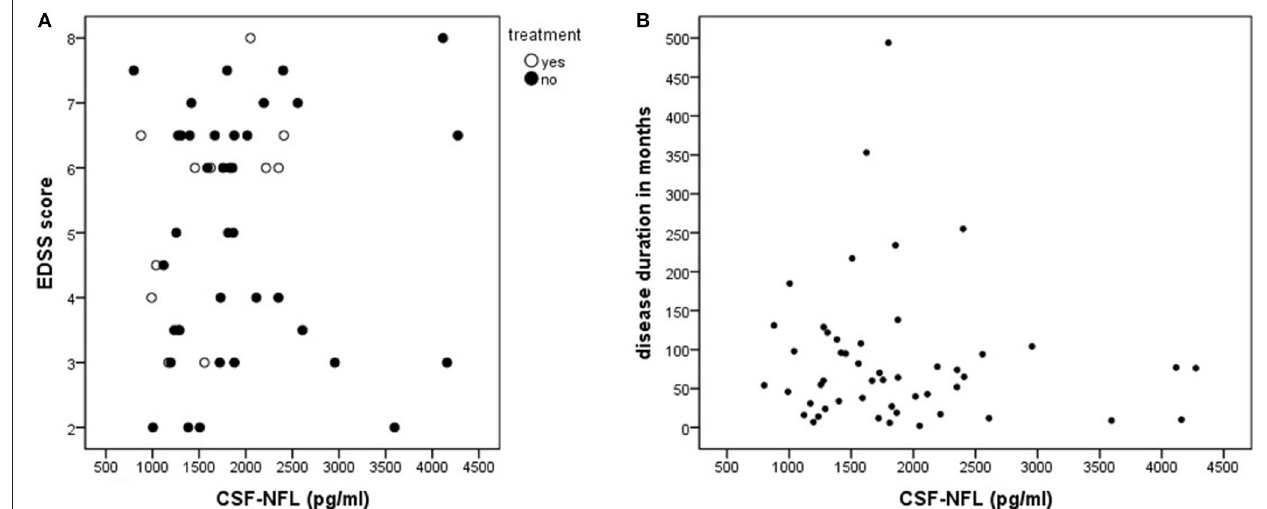
FIGURE 2 | (A,B) The distribution of neurofilament light (NFL) levels in cerebrospinal fluid (CSF) of primary progressive multiple sclerosis patients. EDSS, Expanded disability status scale; HC, healthy controls; PPMS, primary progressive multiple sclerosis. Figure 2A shows the missing relationship between the CSF-NFL concentration and clinical state (EDSS) and current treatment. The CSF-NFL level. Figure 2B illustrates the missing correlation between CSF-NFL and disease